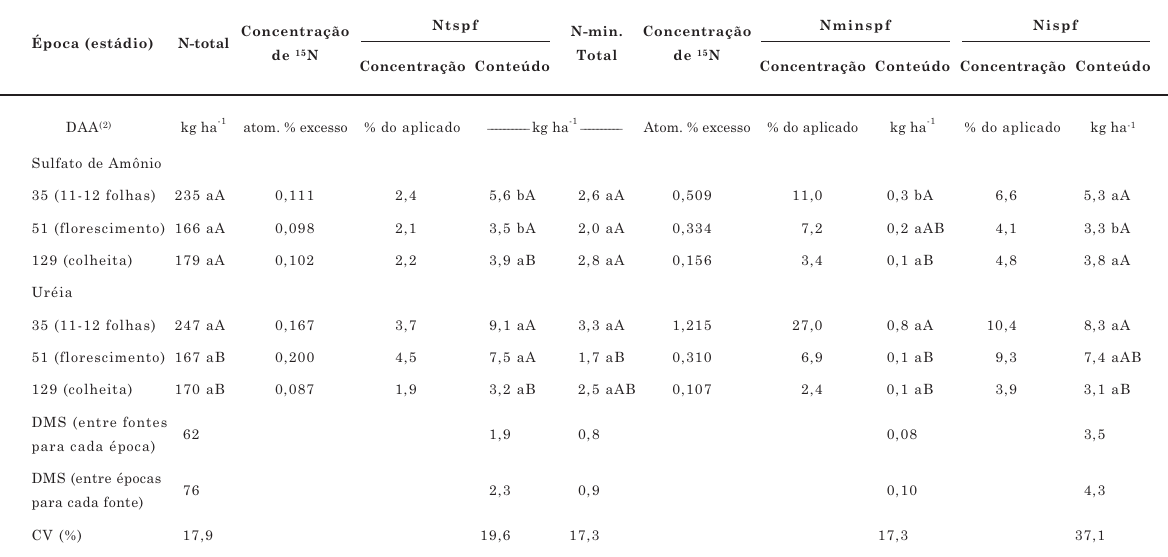
Quadro 3. N total do solo proveniente do fertilizante ( Ntspf ), N mineral do solo proveniente do fertilizante ( Nmispf ), N-imobilizado no solo proveniente do fertilizante ( Nispf ) e fração do N fertilizante imobilizado após a aplicação em cobertura de sulfato de amônio e uréia, para a cultura do milho, em sistema plantio direto